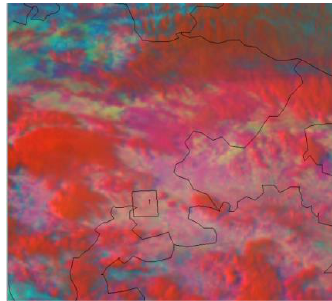
Figure 2. RGB image at 16:38 LST